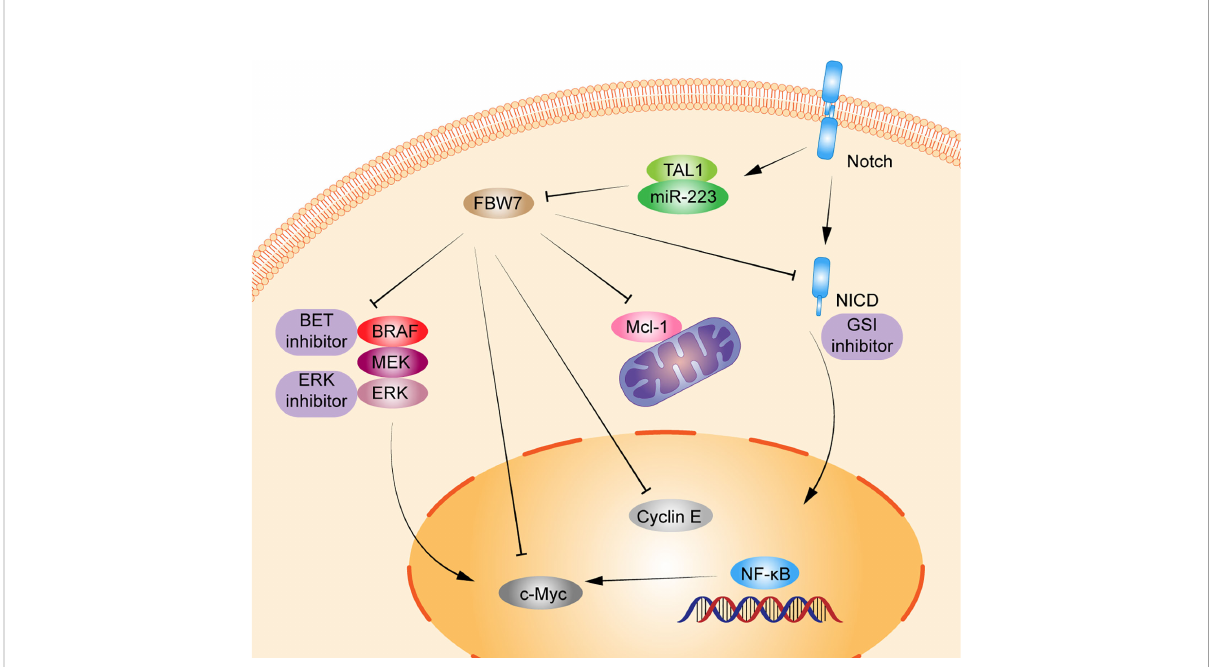
FIGURE 1 Schematic diagram of FBW7-mediated oncogene and signaling pathway in T lymphoproliferative malignancies. 1) Dysregulation of FBW7 can reduce cellular levels of Notch intracellular Domain (NICD) degradation, which leads to abnormal activation of Notch pathway, NF- k B pathway, and affect the expression of its downstream substrates c-Myc, cyclin E. 2) T-cell acute lymphocytic leukemia 1 (TAL1) can upregulate miR-223 expression, thus reducing the expression of FBW7 and increasing the expression of downstream substrates c-Myc, Notch1, cyclin E, and Mcl-1 to induce cell proliferation. 3) FBW7 mutations activate the RAF-MEK-ERK pathway, inhibiting BRAF degradation and providing resistance to BET